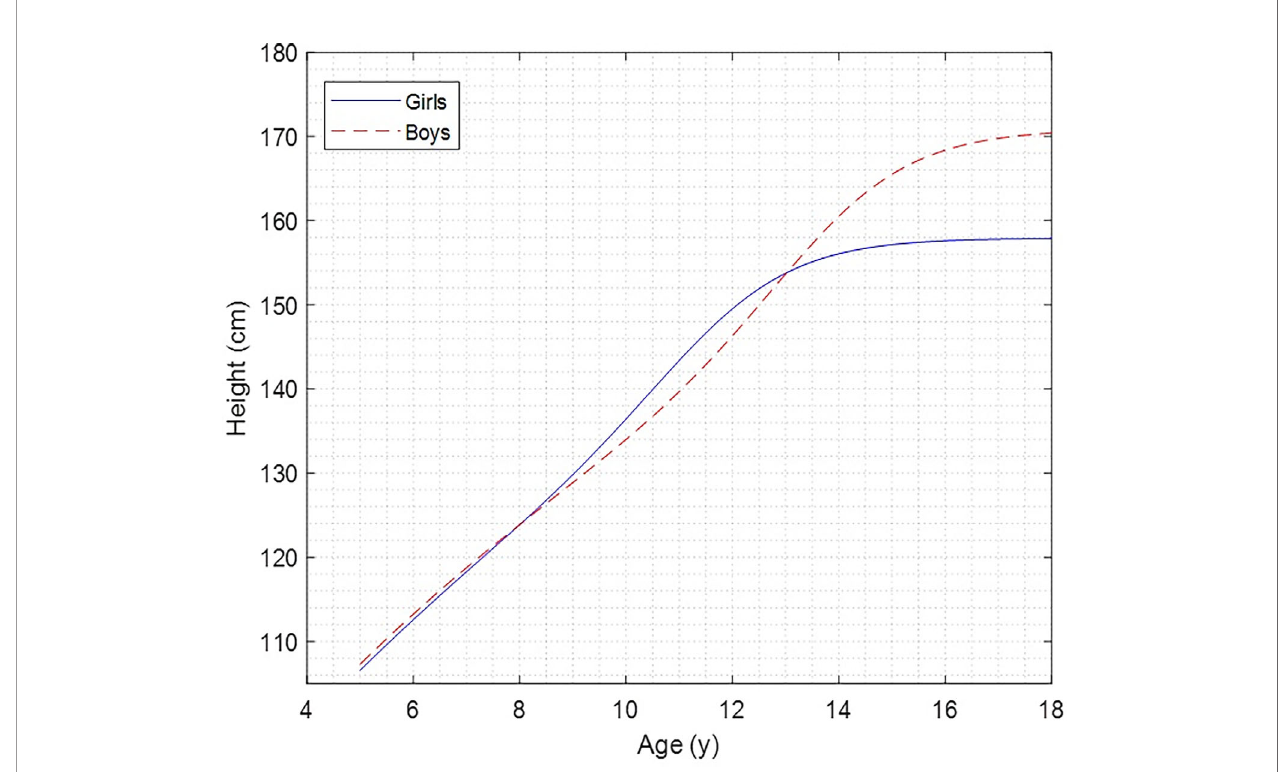
FIGURE 1 | Height growth curve of children and adolescents by age and sex.